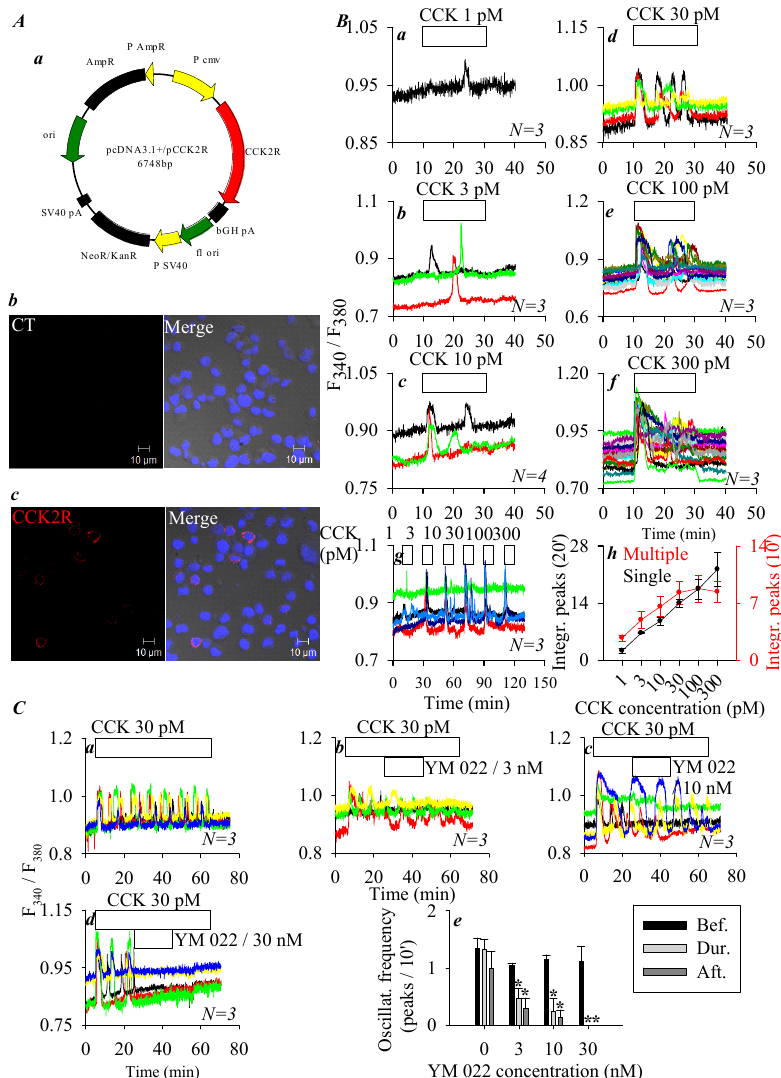
Figure 1. Ectopic expression of cholecystokinin 2 receptors (CCK2R) in CHO-K1 cells. ( A ) CHO-K1 cells were transfected with plasmid pCCK2R ( Aa ), and 48 h after transfection, CCK2R-CHO-K1 cells were fixed and attached to coverslips, incubated sequentially with primary goat anti-CCK2R antibody and TRITC-conjugated donkey antigoat secondary antibody (red), and counterstained with nuclear dye (Hoechst 33342, blue) before confocal imaging ( Ac ). Shown here are fluorescent and merged brightfield images. The controls (with only secondary antibody) done in CCK2R-CHO-K1 cells did not show any fluorescence ( Ab ). Confocal images were taken in a Zeiss LSM 510 META (objective 63×/1.40 oil) with λ ex : TRITC/543 nm and Hoechst 33342/405 nm. Scale bars 10 μ m. ( B ) CCK2R-CHO-K1 cells loaded with Fura-2 AM were attached to coverslips forming the bottom part of a Sykes–Moore perfusion chamber, perifused, and exposed to CCK at 1 ( Ba ), 3 ( Bb ), 10 ( Bc ), 30 ( Bd ), 100 ( Be ), and 300 pM ( Bf ) as indicated by the horizontal bars. ( Bg ) CCK2R-CHO-K1 cells were stimulated sequentially with CCK at 1, 3, 10, 30, 100, and 300 pM. ( Bh ) A quantitative analysis was performed, and the calcium peak areas above the baseline in ( Ba–Bf ) were calculated (from 10–30 min, black curve). The calcium peak areas above the baseline in ( Bg ) were calculated for 10 min periods (10–20, 30–40, 50–60, 70–80, 90–100, and 110–120 min, red curve). ( C ) CCK2R-CHO-K1 cells loaded with Fura-2 AM were attached to the coverslip bottoms of Sykes–Moore perfusion chambers, perifused, and exposed to CCK 30 pM and YM 022 at 0 ( Ca ), 3 ( Cb ), 10 ( Cc ), and 30 nM ( Cd ), as indicated. ( Ce ) A quantitative analysis was done for the original tracings shown in ( Ca–Cd ); the number of calcium peaks per 10 min before, during, and after perfusion of YM 022 is presented. Student’s T -test was performed, statistically significant di ff erence is indicated by an asterisk (*) at p < 0.05. Representative calcium tracings from N identical experiments ( N = 3–4) are shown in ( Ba – Bg , Ca – Cd